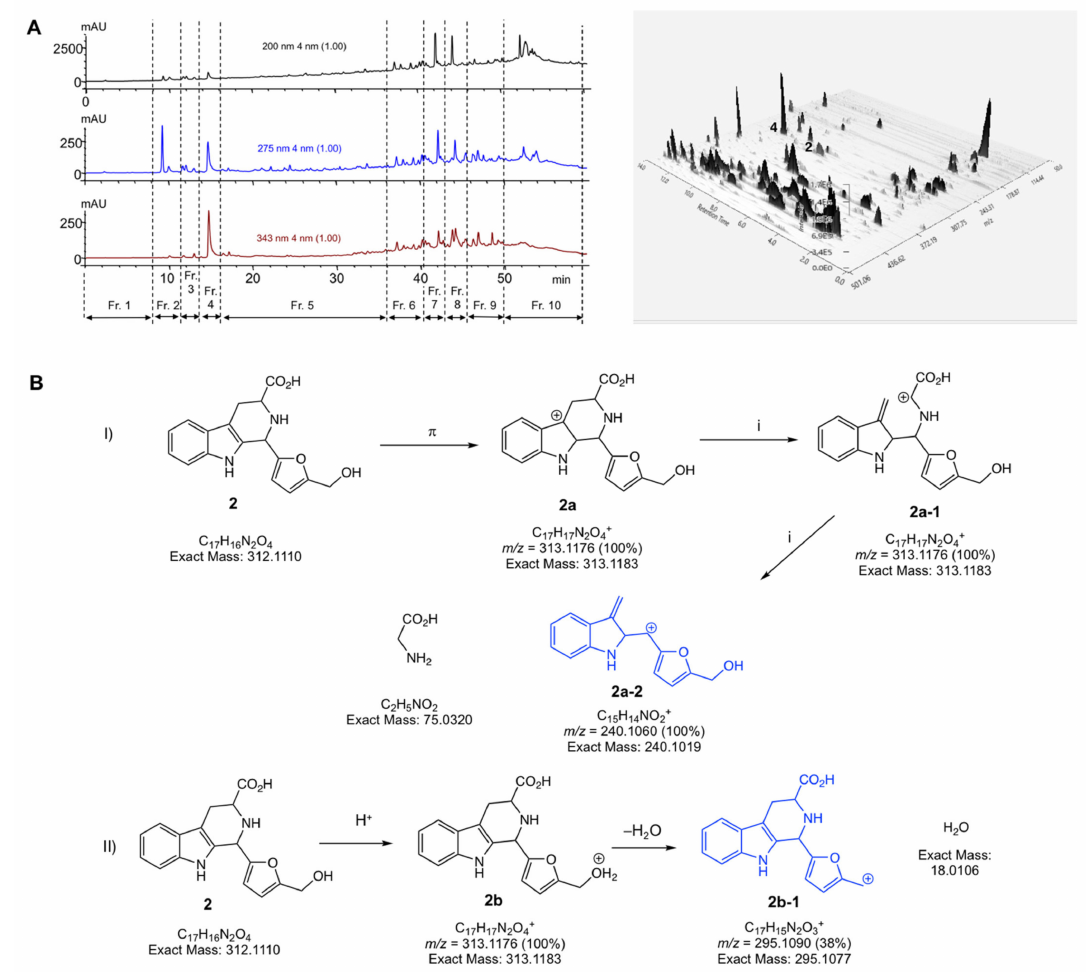
Figure 2. ( A ) HPLC and 3D LC/MS metabolite profiling of Crassostrea gigas ethanolic extract; ( B ) Pro- posed mass fragmentation pathway of compound 2 (Symbols: π referred to ionization on π bond, i: referred inductive cleavage, H + : protonation, − H 2 O: dehydration). MS/MS fragmentation showing, (I): Prominent product ion 2a at m/z 240.1019 and mass neutral loss: 75.0320 (C 2 H 5 NO 2 ); (II): Promi- nent product ion 2b-1 at m/z 295.1077 and neutral loss: 18.0106 (C 2 H 5 NO 2